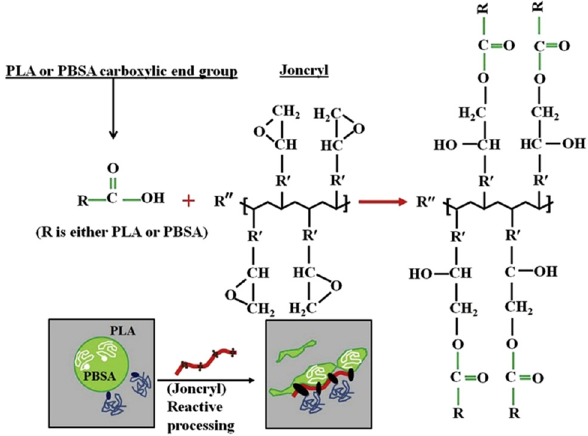
Figure 5: Generalized reaction mechanism of Joncryl - PLA and/or PBSA carboxyl end groups ( 57 ) . Copyright 2015. Reproduced with permission from